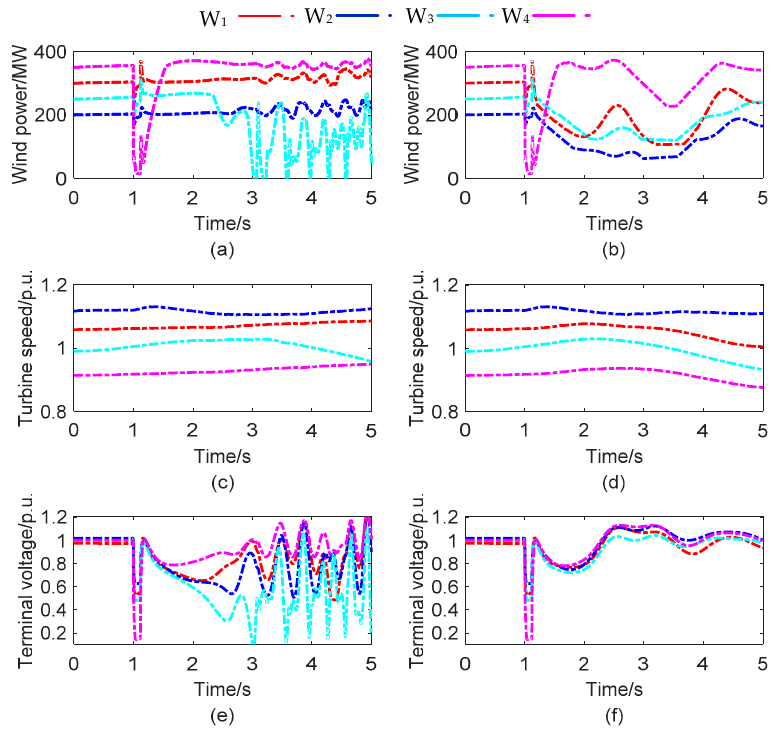
Figure 11. WT dynamics of ( a ) wind power; ( c ) turbine speed; and ( e ) terminal voltage without PEC; DFIG dynamics of ( b ) wind power; ( d ) turbine speed; and ( f ) terminal voltage with PEC.